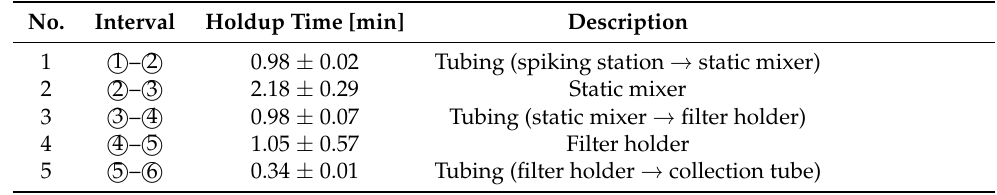
Table 1. Holdup time